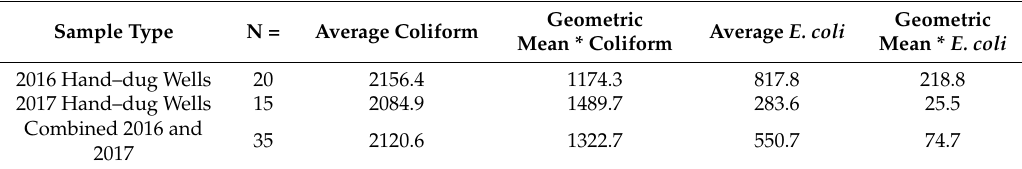
Table 1. Hand–dug well bacterial water quality